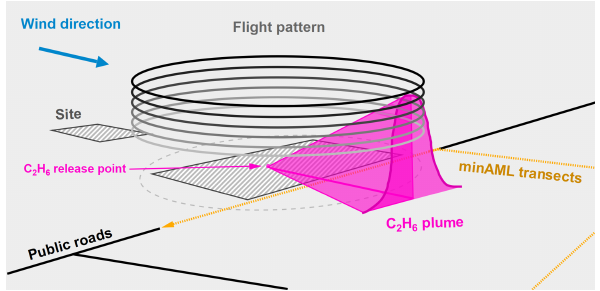
Figure 1. Experimental schematic of tracer release (ethane; C 2 H 6 ) at a dairy farm, as observed by a small aircraft and miniature Aero- dyne Mobile Laboratory (minAML). In this ideal scenario, the wind is carrying the plume across the site perpendicular to accessible public roads. Table 1. Overlap between flight times and release of tracer gas (ethane) over the course of the field campaign.